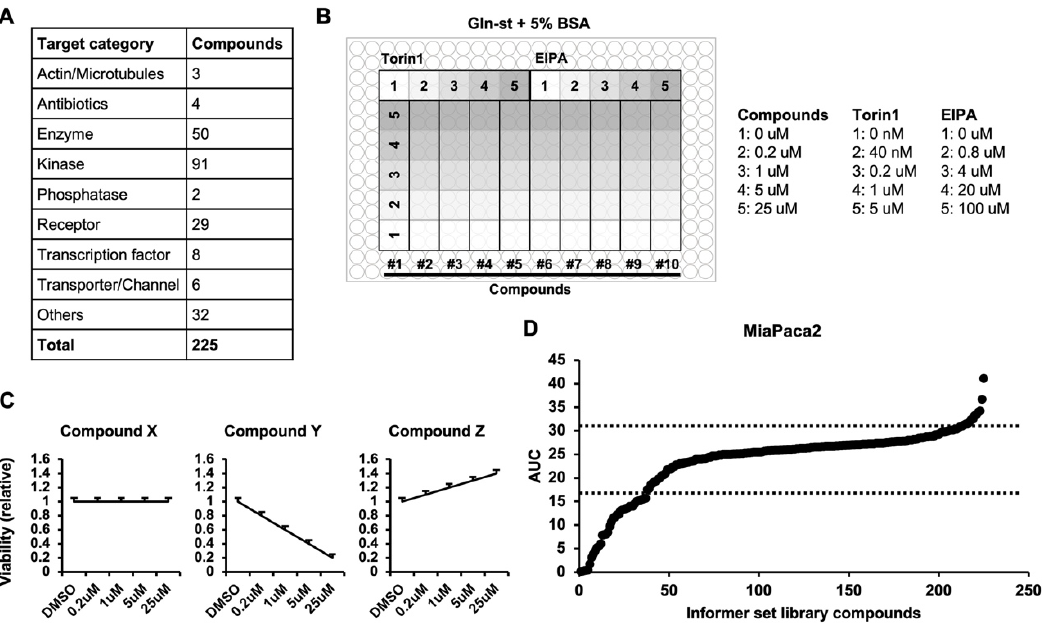
Figure 2. Macropinocytosis regulator screen using the Informer set library. ( A ) Categories of known targets for the 225 compounds composing the Informer set library. ( B ) Plate settings used in the screen demonstrating the treatment concentrations of library compounds, Torin1, or EIPA used in the screening process. ( C ) Examples of AUC calculated from the relative viability of cells treated with individual compounds indicating no change (Compound X), decrease (Compound Y), or increase (Compound Z) in viability. ( D ) Alignment of AUC value of all 225 compounds with the cut-off for positive regulators and negative